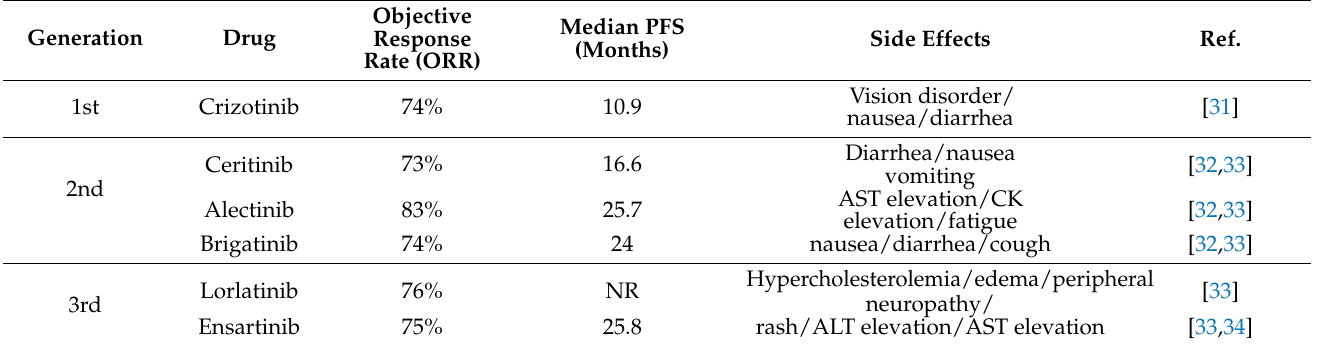
Table 2. Summary of FDA-approved